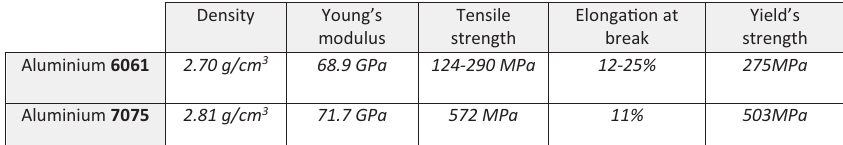
Figure 5. Table of the mechanical properties of aluminum